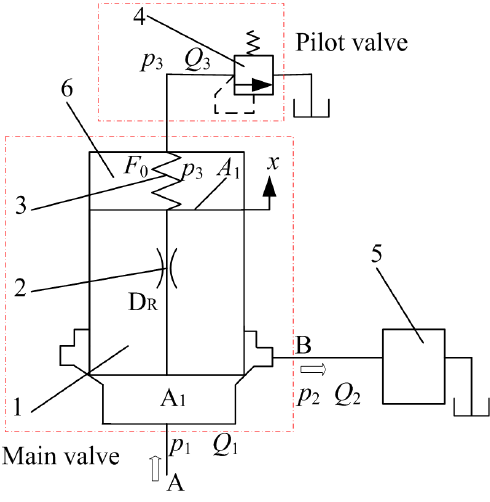
Figure 2. Working principles of the PRV (1—Main valve spool; 2—Orifice; 3—Reset spring; 4—Pilot valve; 5—HERU; 6—Spring chamber).